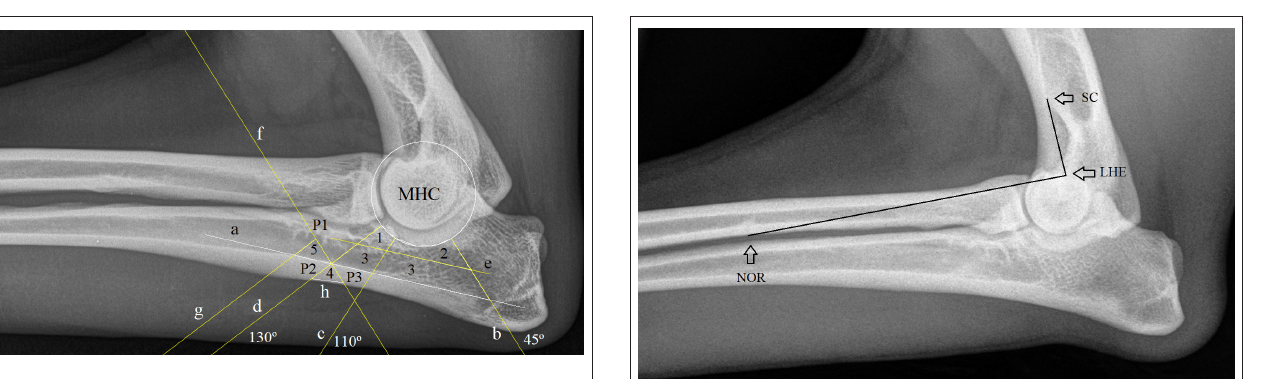
FIGURE 1 | Regions of interest (ROIs) created in ImageJ: A sequence of instructions requiring some user input and performing some logical steps was created as a text file in the ImageJ programming language. For ImageJ, such a list is called a “macro.” Line “a” is drawn by the user as a tangent to the caudoproximal endosteal surface of the ulna, and three points are identified by mouse clicks on the edge of the medial humeral condyle (MHC). This user input allows for the automatic creation of the circular outline of the humeral condyle, together with three lines originating in the center of the MHC at angles of 45 ◦ “b,” 110 ◦ “c,” and 130 ◦ “d” to line “a,” a line “e” parallel to line “a” dividing the area bounded by lines “a,” “b,” and “d” and the humeral condylar, into two regions with areas in the ratio 1 (upper/cranial) to 2 (lower/caudal); line “f” is created again automatically by the macro, perpendicular to line “d” through the point of intersection between lines “d” and “a.” Finally, the user marks three points: P1 at the intersection of line “f” with the ulnar cranial endosteal cortex, and P2 and P3 at the points where lines “d” and “f” cross the periosteal caudal ulnar cortex, respectively. This allows the automatic creation of line “g,” which is parallel to line “d” and passes through P1, and line “h,” which joins P2 and P3. The macro then creates ROIs as follows: ROI-1, distal ulnar trochlear notch (UTN); ROI-2, middle UTN; ROI-3, caudal UTN (single area); ROI-4, cortical bone; ROI-5, bone marrow. The macro takes measurements from these five ROIs. The recorded measurements for each were mean, median, standard deviation, and area. The completed macro sequence thus creates lines and regions according to strict reproducible criteria.